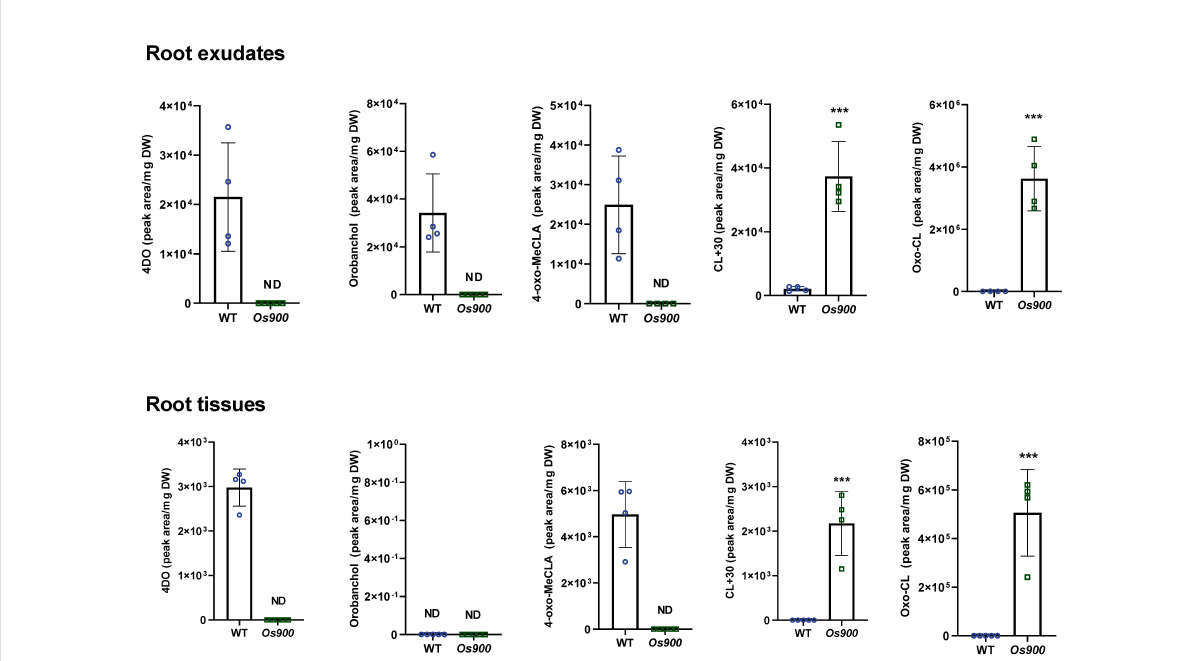
FIGURE 1 SL pro fi le of WT and max1-900 mutants grown under Low Pi conditions. Canonical and non-canonical SLs were quanti fi ed by LC-MS in root exudates and tissues. Bars represent mean±SD; n =4 biological replicates. Statistical analysis was performed using two-tail student t-test. Asterisks indicate statistically signi fi cant differences as compared to WT (***p< 0.001).. DW; dry